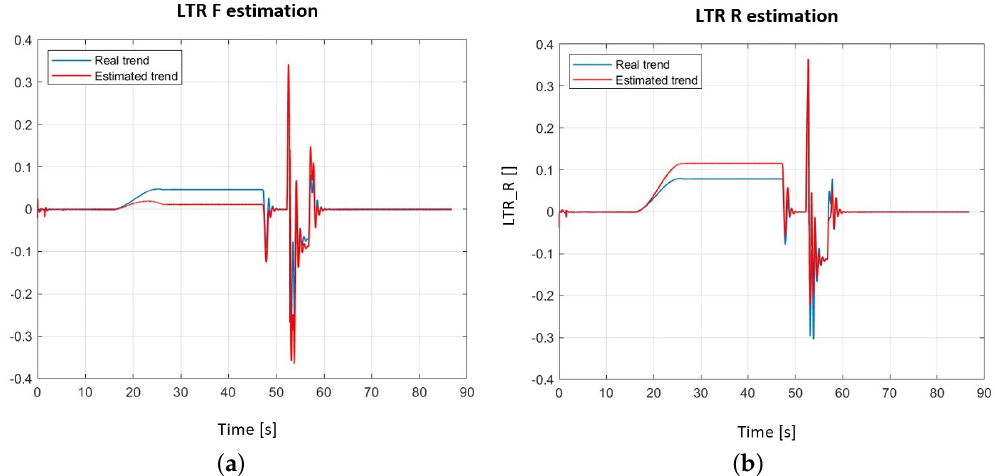
Figure 8. Estimation of the vehicle Load Transfer Ratio at front ( a ) and rear ( b ) axles during a FishHook